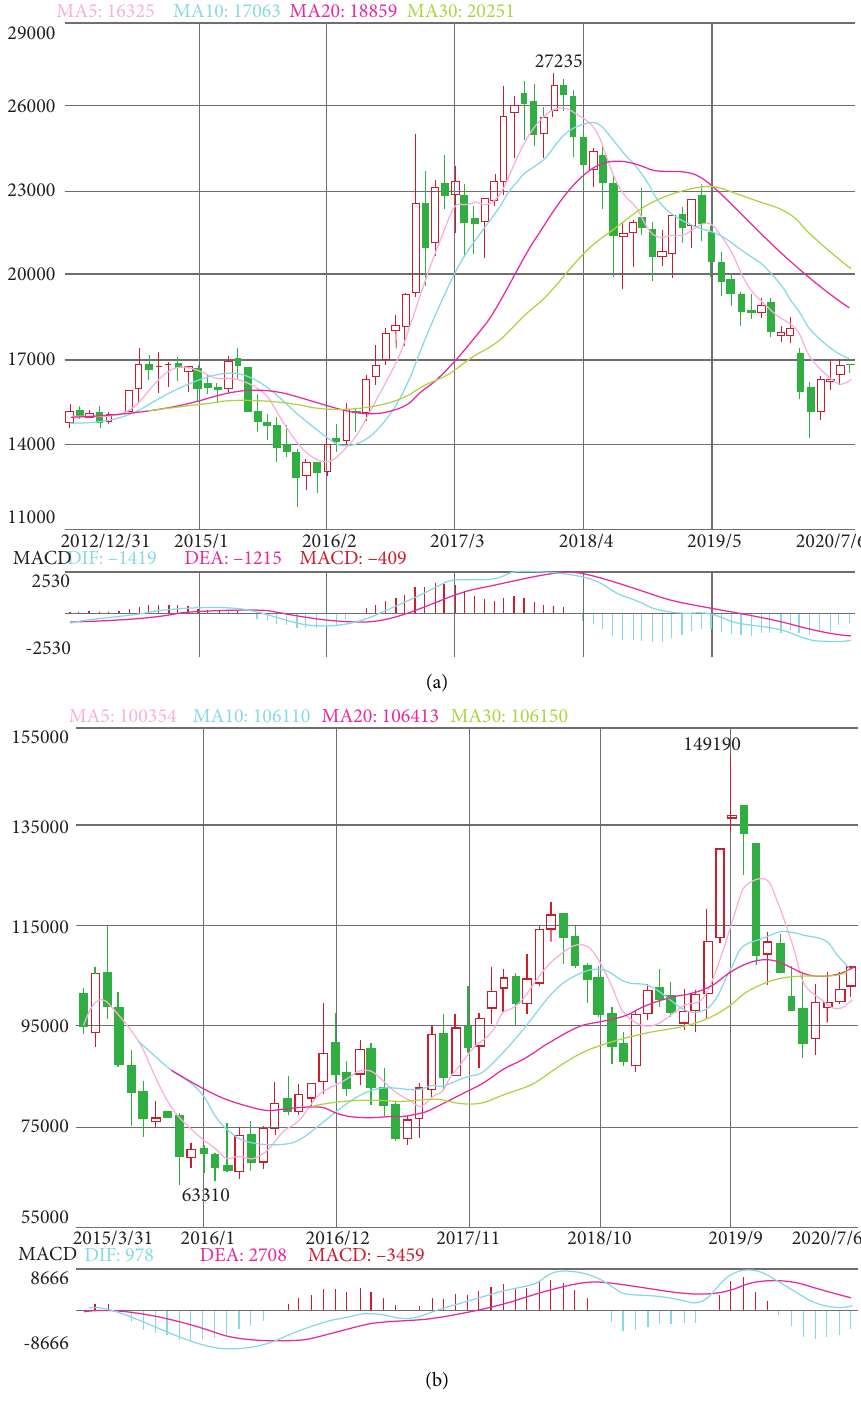
Figure 11: The fluctuation of main future prices of zinc and nickel at the Shanghai stock exchange. (a) Zinc. (b)